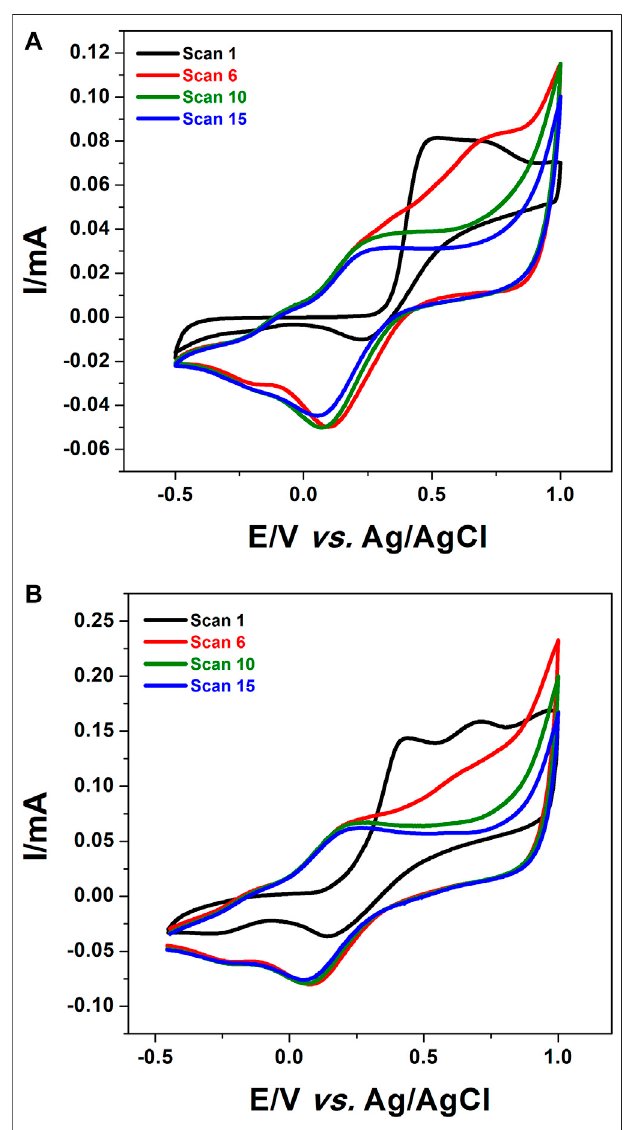
FIGURE 1 | CV of (A) CPE and (B) f-MWCNT/CPE in 0.1 M HCl containing 5 mM 1,8-DAN for 15 cycles at a scan rate of 50